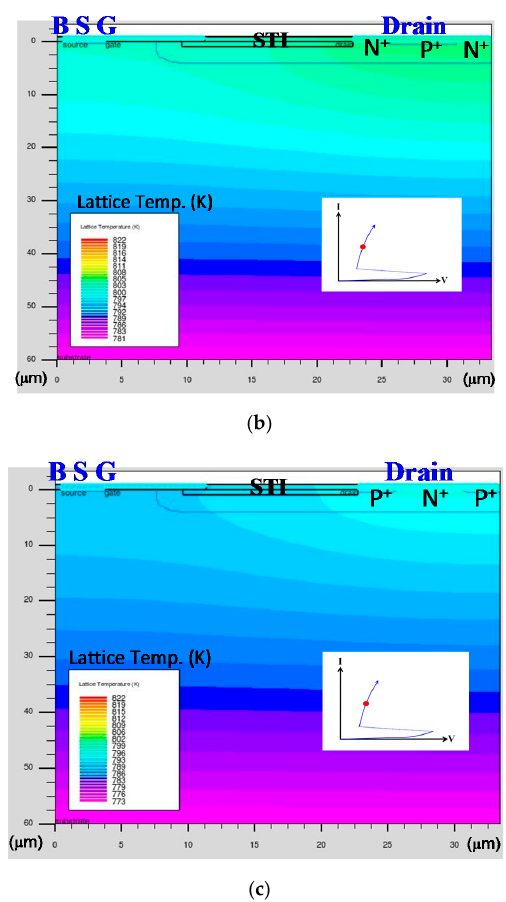
Figure 11. Lattice temperatures distribution of 60 V HV nLDMOS ( a ) reference device, ( b ) drain-side n-p-n -arranged type, and ( c ) drain-side p-n-p -arranged type stressing at the same trigger condition.